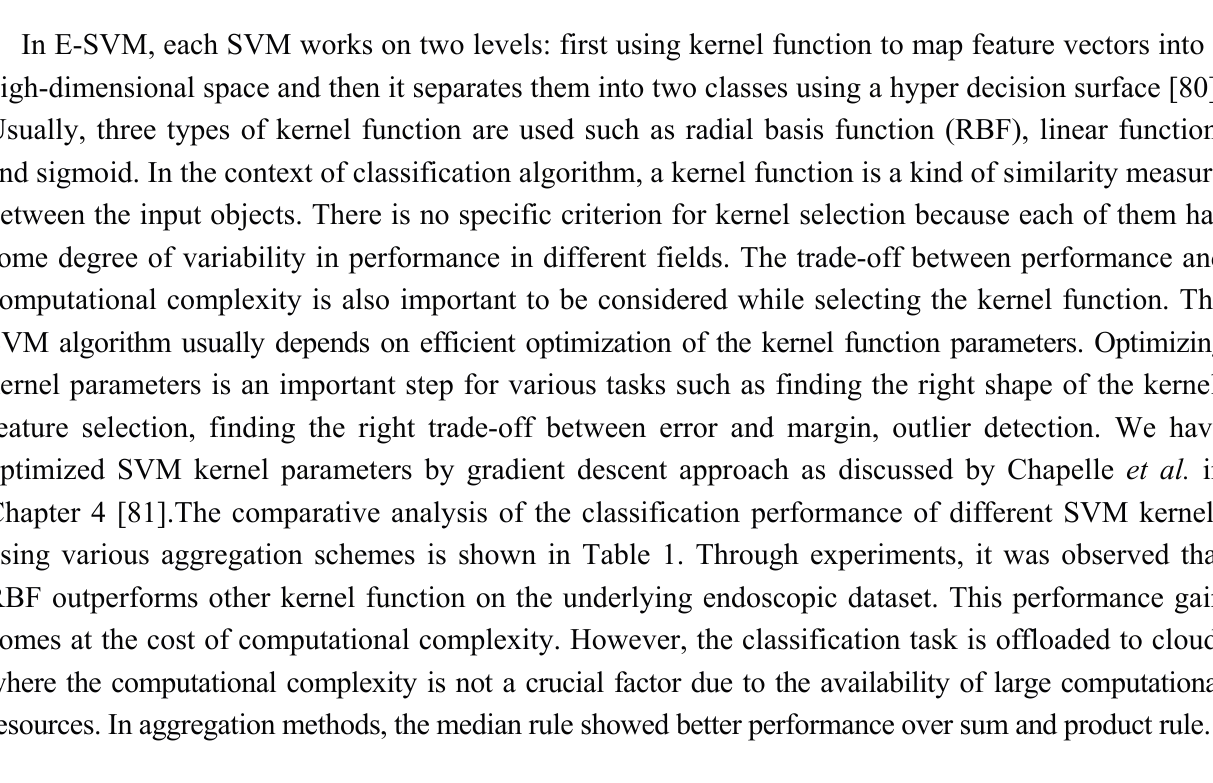
Table 1. The comparative analysis of the classification performance of different SVM kernels using various aggregation